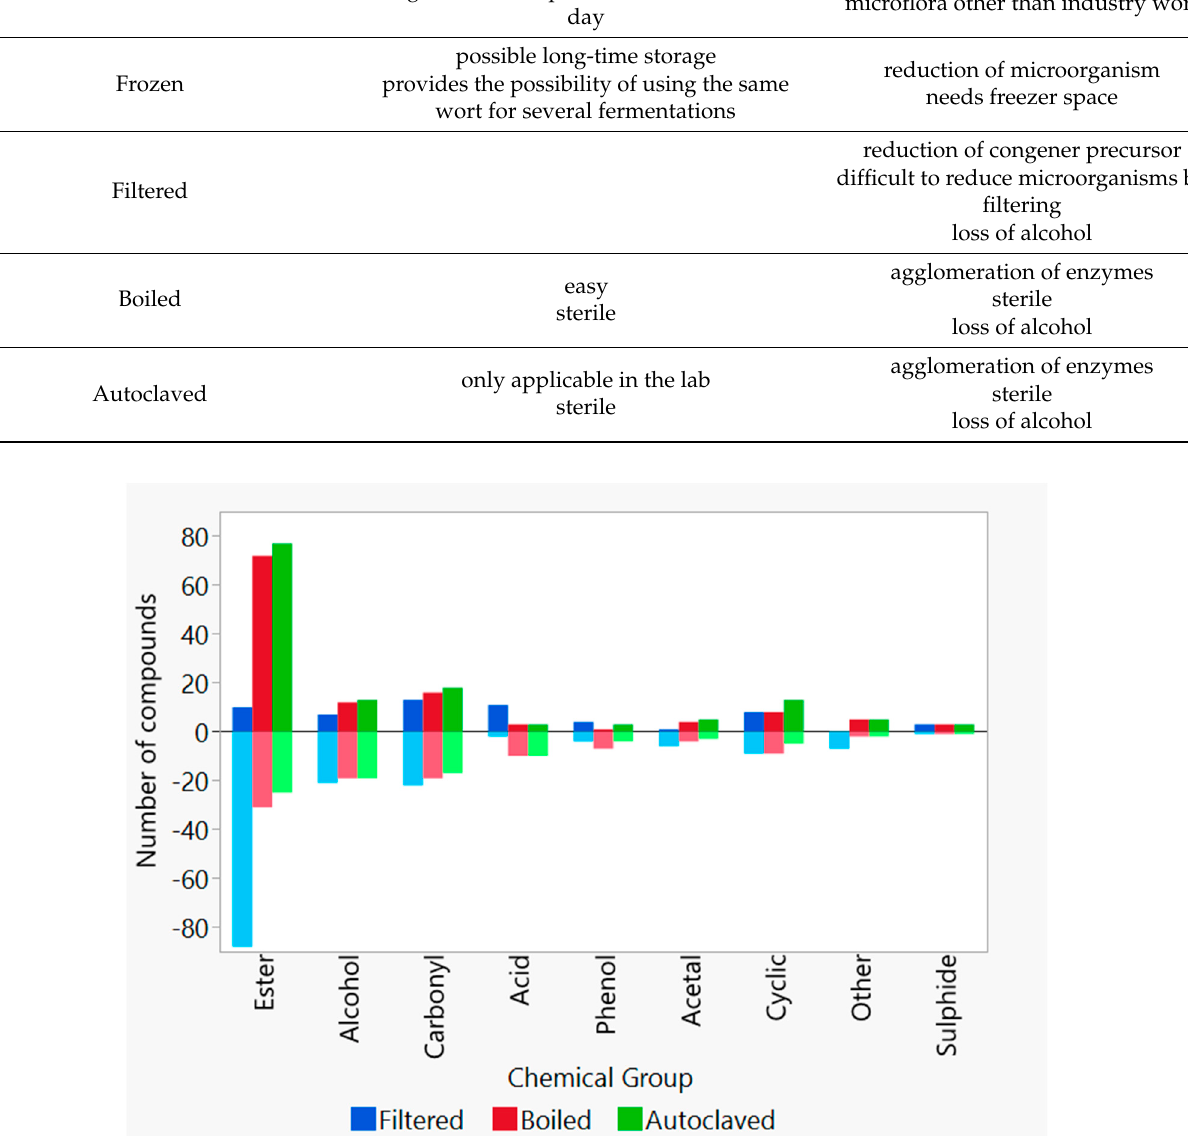
Figure 7. Number of compounds that showed an increased or decreased peak area, in comparison to the control wort, separated by the main nine chemical groups.